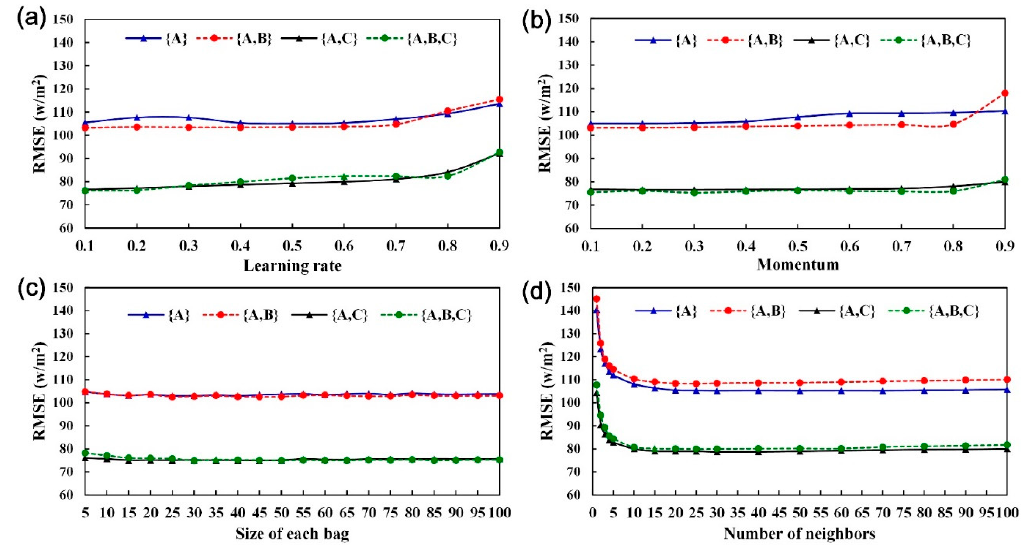
Figure 4. Calibration of model parameters: ( a ) learning rate for MLP; ( b ) momentum correction for MLP; ( c ) size of each bag for RF; and ( d ) number of neighbors for k NN.